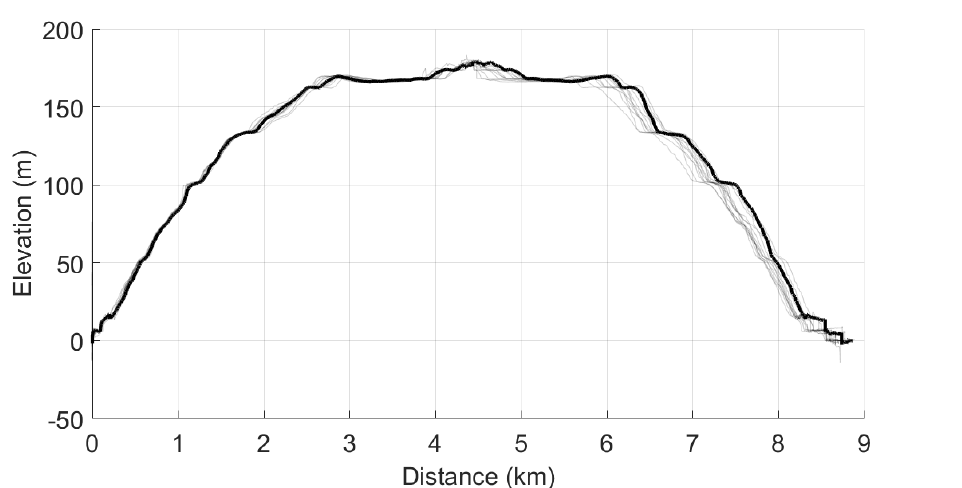
Figure 5. The measured relative elevation during the 13 drive-cycles used in the model calibration. One drive cycle has been highlighted for